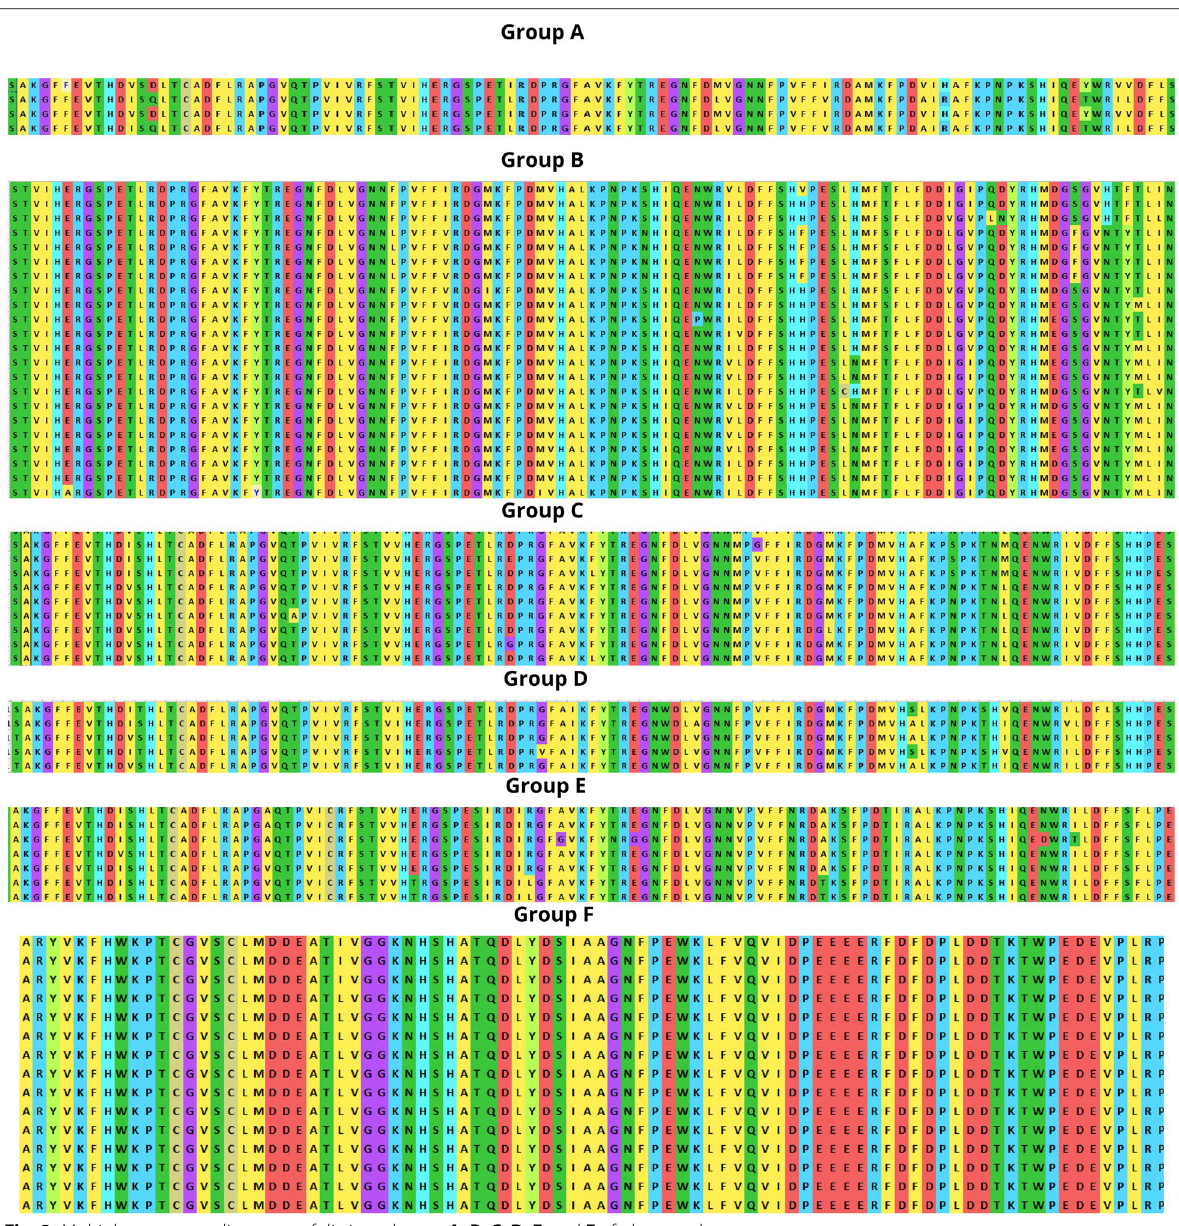
Fig. 2 Multiple sequence alignment of distinct clusters A, B, C, D, E , and F of plant